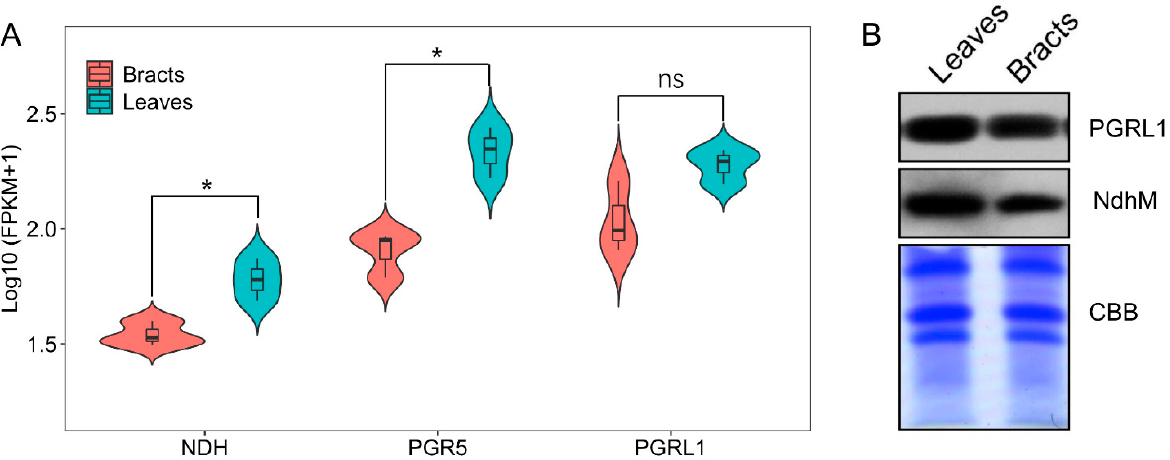
Figure 1. Differences in transcription and protein levels of cyclic electron flow. ( A ) Differences in the expression of electron-related genes in cotton leaves and bracts. Solid lines within the box indicate the mean values, box boundaries indicate upper and lower quartiles; The width of spindles denotes the accumulation of high samples. Bars indicate SD ( n = 3). “*” and “ns” denotes significance at the 0.05 level and non-significant between the leaves and bracts based on an analysis of variance, respectively. ( B ) Coomassie brilliant blue (CBB)-staining PAGE profiles and Western analysis of total PGR5-like photosynthetic phenotype 1 (PGRL1) (1:1000) and NAD(P)H-quinone oxidoreductase subunit M (NdhM) (1:1000) in the thylakoid membranes of cotton leaves and bracts. Lanes were loaded with thylakoid membrane proteins corresponding to 1 μ g and 10 μ g chlorophyll for Western analysis and CBB, respectively.